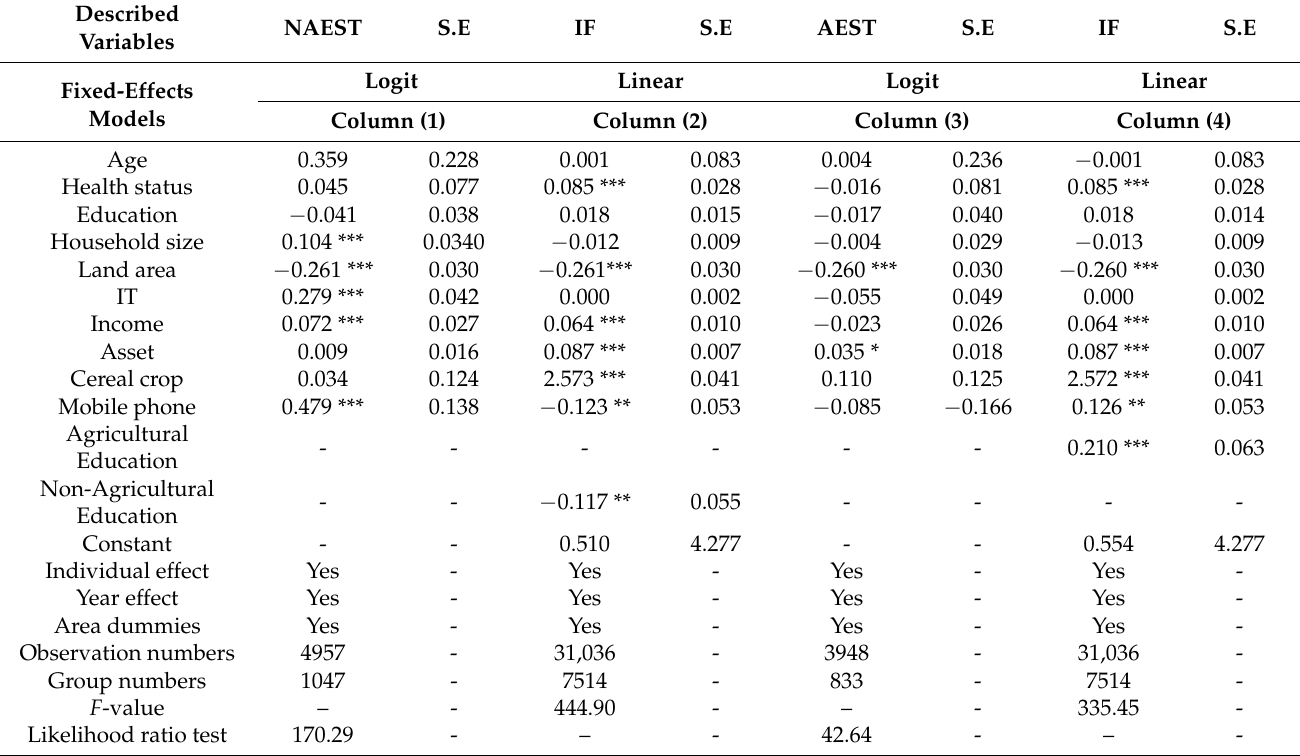
Table 3. Mediating impacts of human capital between mobile phone and IF